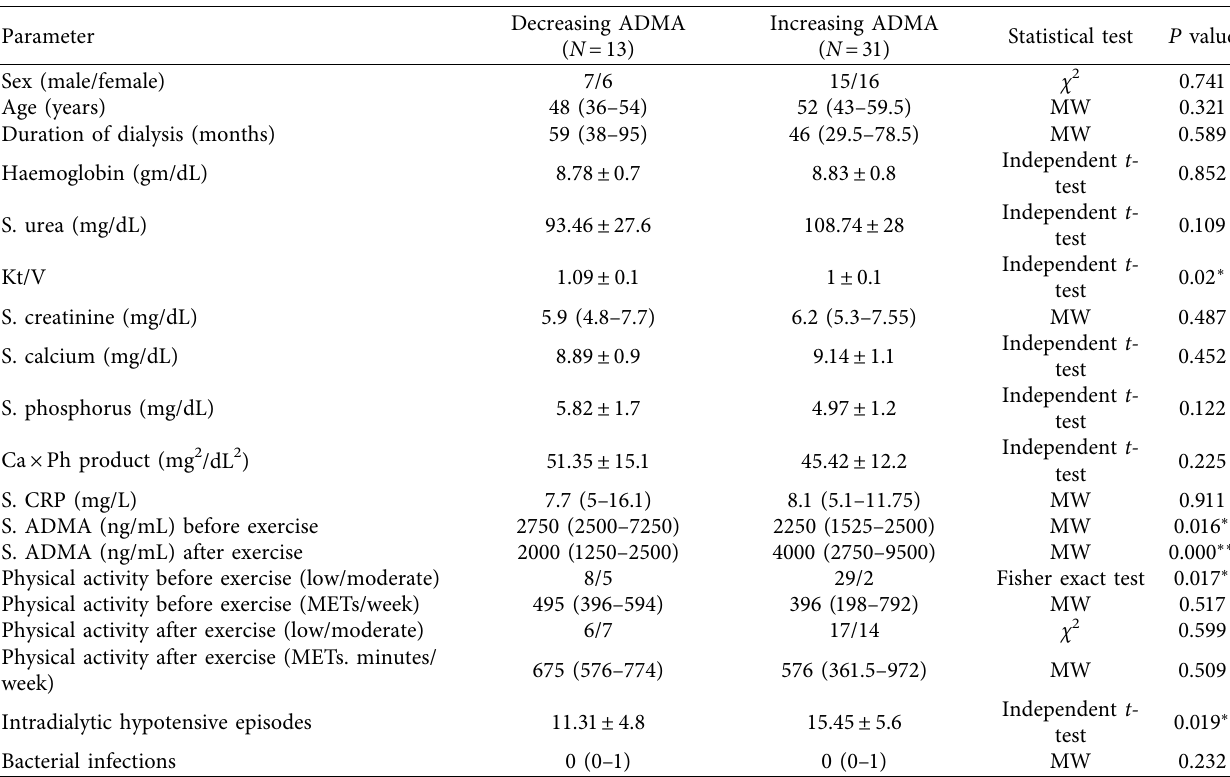
Figure 2: Serum ADMA before and after 6 months of peridialytic exercise. Table 2: Comparison of patients with decreasing/stable S. ADMA to patients with increasing S.